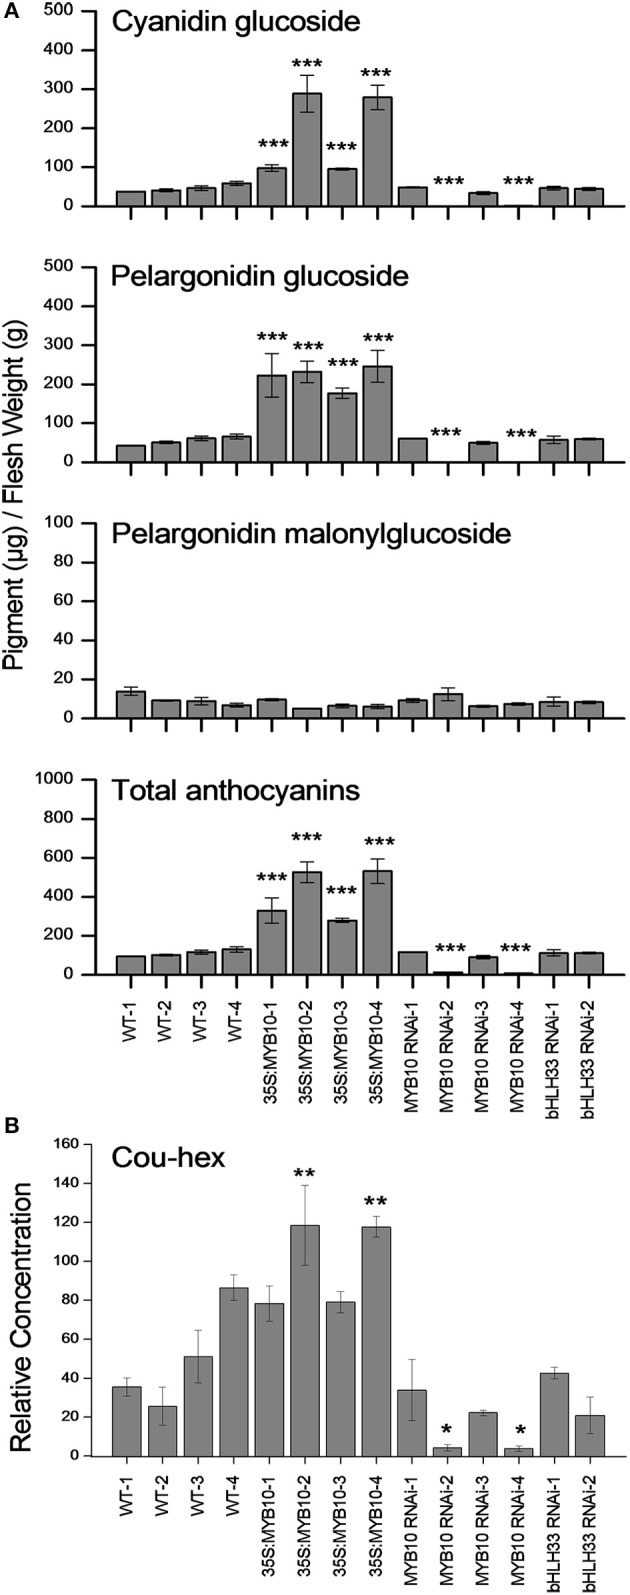
Concentrations of anthocyanins and p-coumaryl glucose in the mature fruit of 35S:FvMYB10, FvMYB10 RNAi, FvbHLH33 RNAi, and wild-type controls. The two main anthocyanins, cyanidin glucoside and pelargonidin glucoside, were elevated in 35S:FvMYB10 lines and barely detectable in two FvMYB10 RNAi lines. The third anthocyanin compound, pelargonidin malonylglucoside, remained at low concentrations in all fruit. There was no significant difference in anthocyanin concentration between FvbHLH33 RNAi lines and wild-type controls (A). P-coumaryl glucose (Cou-hex) correlated with two main anthocyanin compounds (cyanidin glucoside and pelargonidin glusoside) (B). Errors bars are the SE for three biological replicates. Statistical significance between transgenic lines and wild-type controls was determined by One-Way ANOVA: *P < 0.05; **P < 0.01; ***P < 0.001.